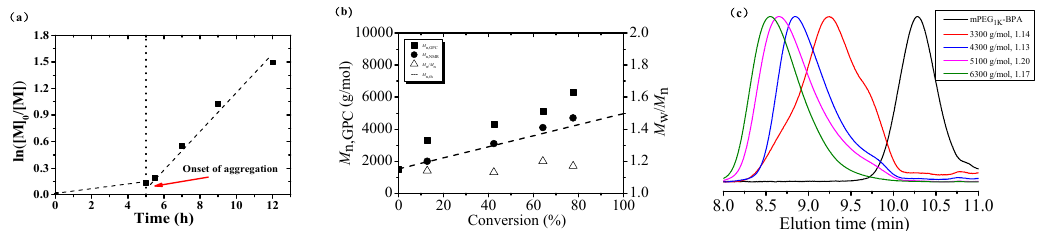
Figure 2. ln([M] 0 /[M]) as a function of time ( a ), number-average molecular weight ( M n,GPC ) and molecular weight distribution ( M w / M n ) versus monomer conversion ( b ) and GPC elution curves ( c ) for photo-BIT-RDRPof BnMA. Polymerization conditions: [BnMA] 0 /[mPEG 1k -BPA] 0 /[NaI] 0 /[TEA] 0 = 20/1/2/0.5, V BnMA = 50 μ L, V methanol = 0.5 mL, under irradiation with blue LED light ( λ max = 464 nm, 0.15 mW/cm 2 ) at room temperature (25 °C); BnMA concentration at 20.0 wt %.